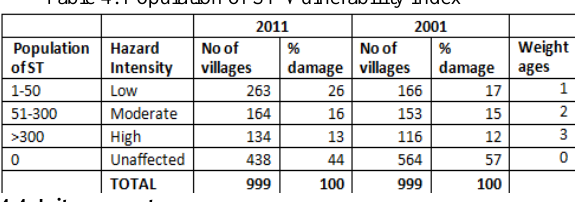
Table 4: Population of ST Vulnerability Index